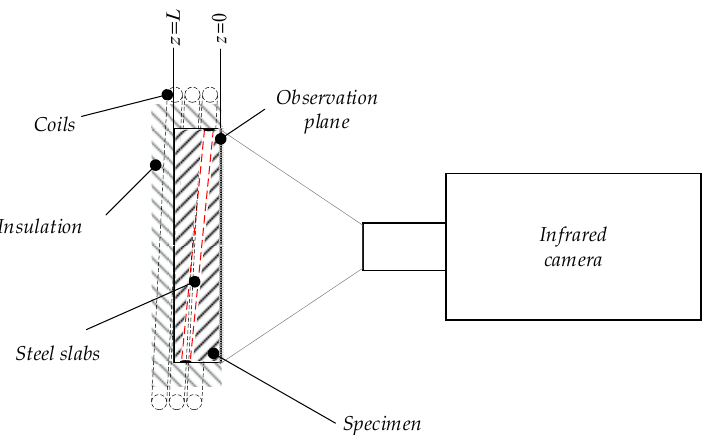
Figure 2. Boundaries that were applied to the experimental setup.